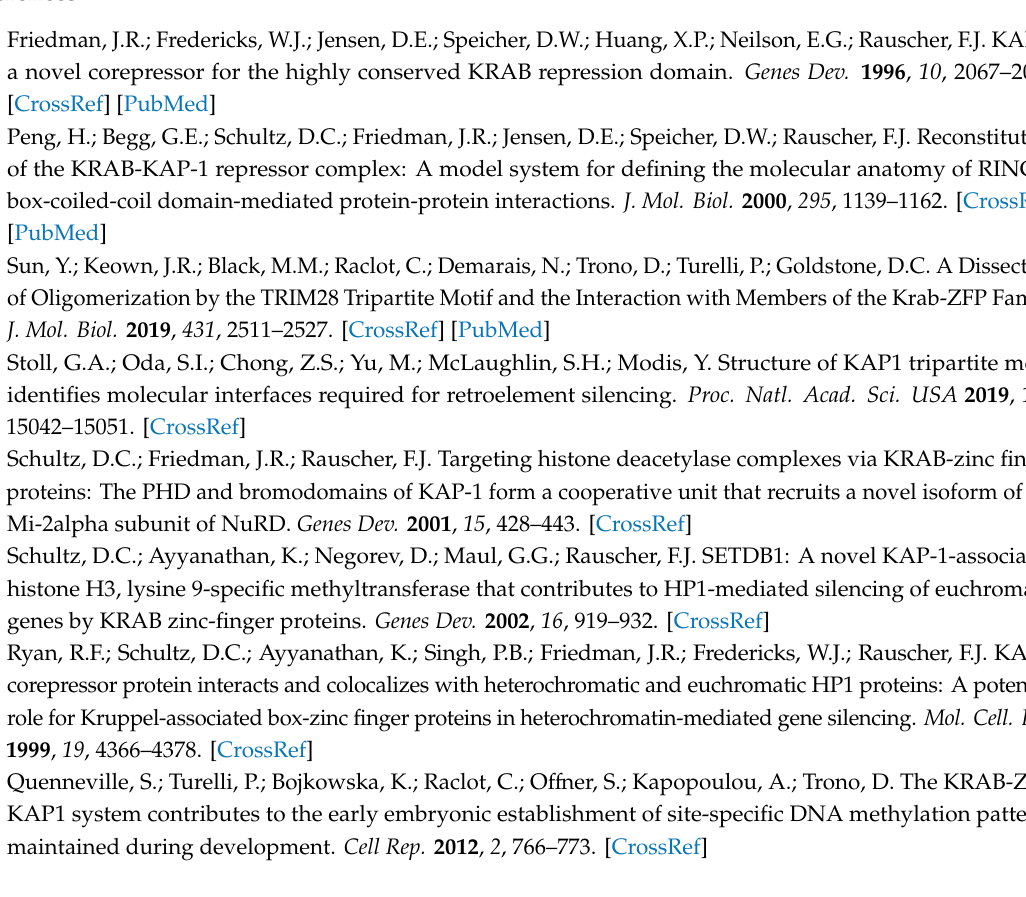
Table S1.2 Pathway analysis with Trim28 KD vs. control 3T3-L1 at day 2 by using KEGG pathway database, Table S1.3 Bioinformatics analysis with Trim28 KD vs. control 3T3-L1 at day 0 by using GO database, Table S1. 4 Bioinformatics analysis with Trim28 KD vs. control 3T3-L1 at day 2 by using GO database, Table S2. Sequences of CpG dyads at Dlk1-Gtl2 locus, Table S3. Primers for real-time PCR, Table S4. The di ff erentially expressed